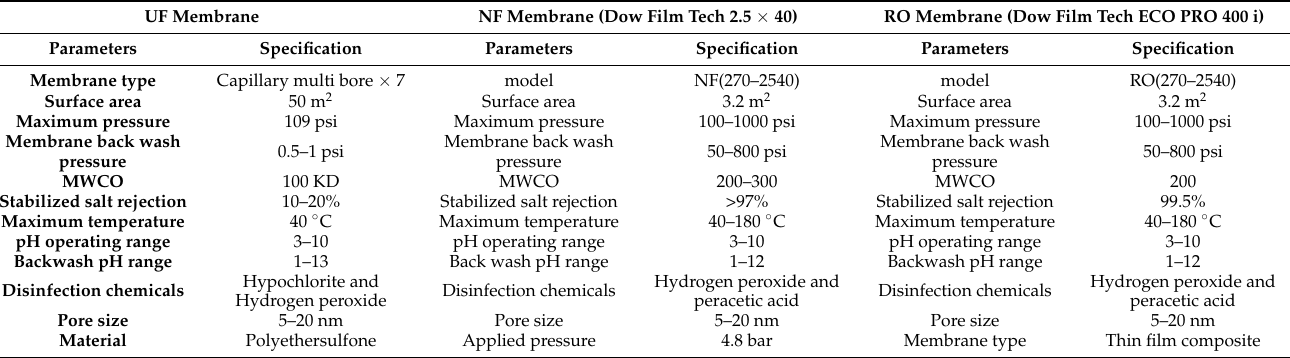
Table 1. Characteristic properties of UF, NF and RO